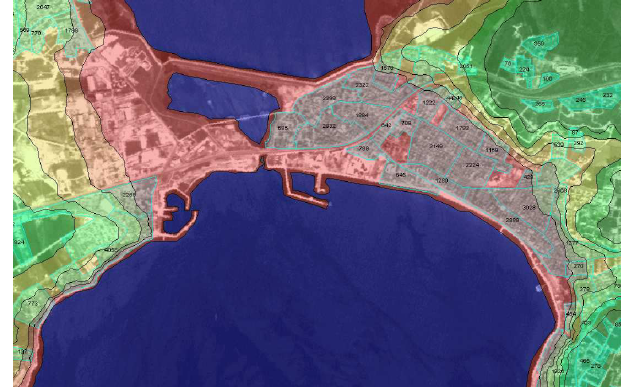
Figure 20: areas of a certain run-up risk for Tsunamis overlaid with land-use data and population density of residential